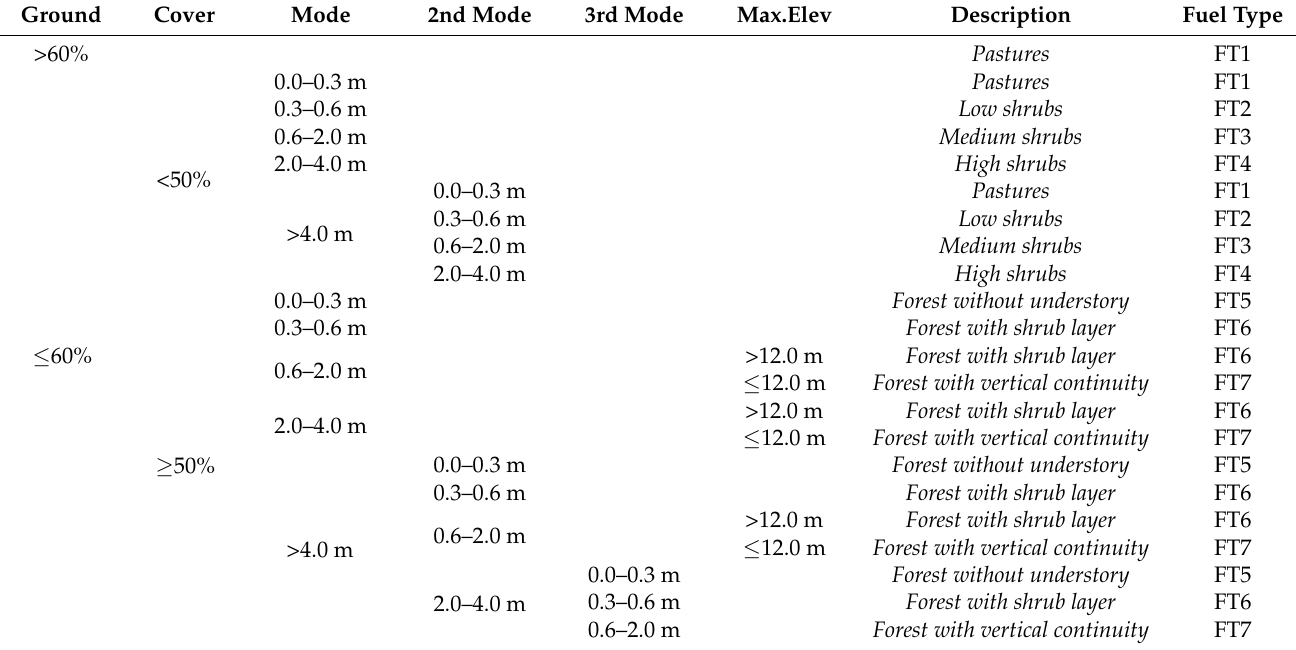
Table 2. Fuel type classification system used for the LiDAR